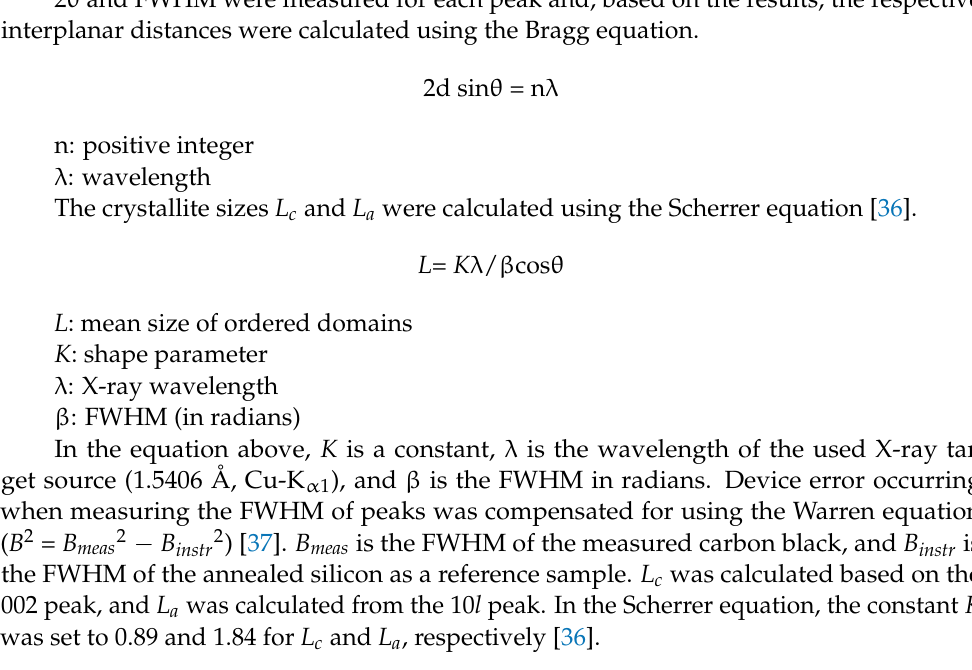
Figure 1. XRD pattern of raw carbon black and fitting of XRD patterns of carbon black using two Gaussian peaks (LDCC: less-developed crystalline carbon, MDCC: more-developed crystalline carbon). The 10 l peak near 43 ◦ was analyzed as follows. The background was first removed in the range between 35–60 ◦ ; then, Gaussian fitting was applied to remove the 102 peak near 52 ◦ . Following that, the 2 θ and full width at half maximum (FWHM) of the peak were